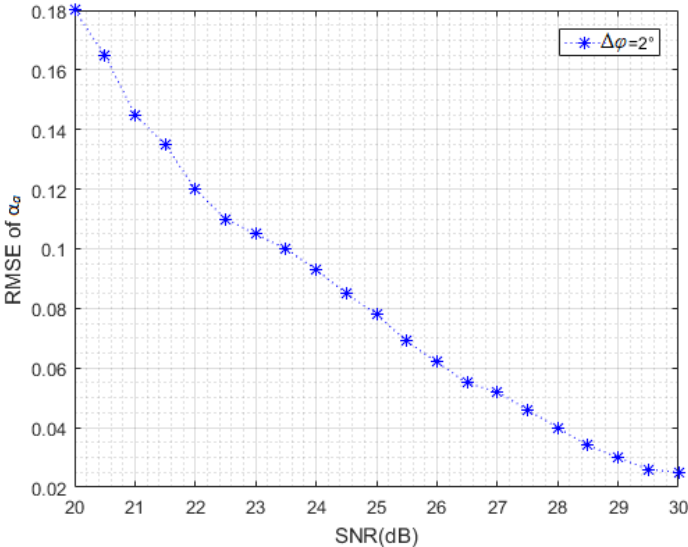
Figure 9. RMSE of α a versus SNR for ψ = 45°and Δφ = 2°.